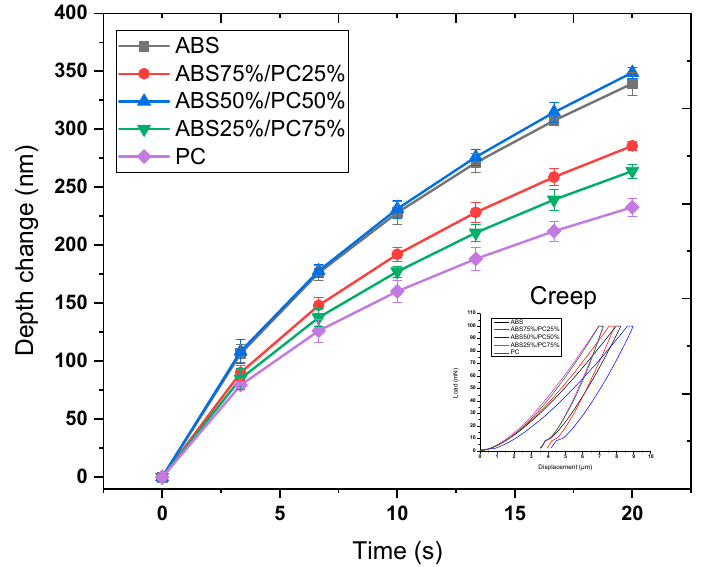
Figure 7. Creep time vs. depth change of neat ABS, PC, and blends of ABS/PC.